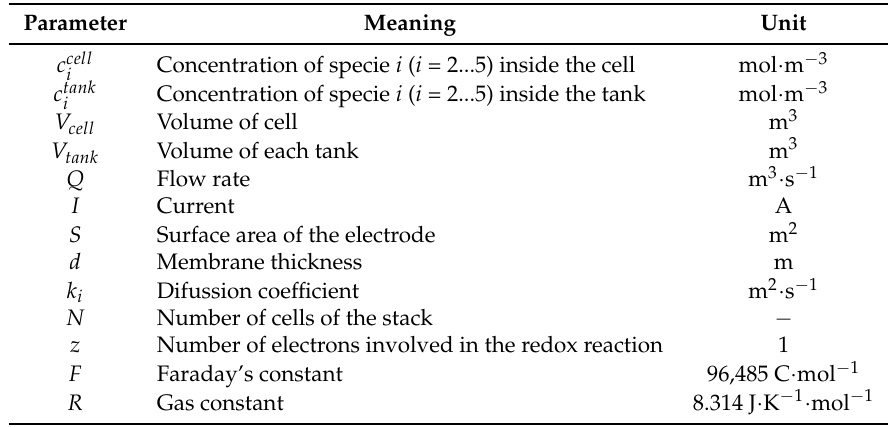
Table 7. Parameters of the electrochemical